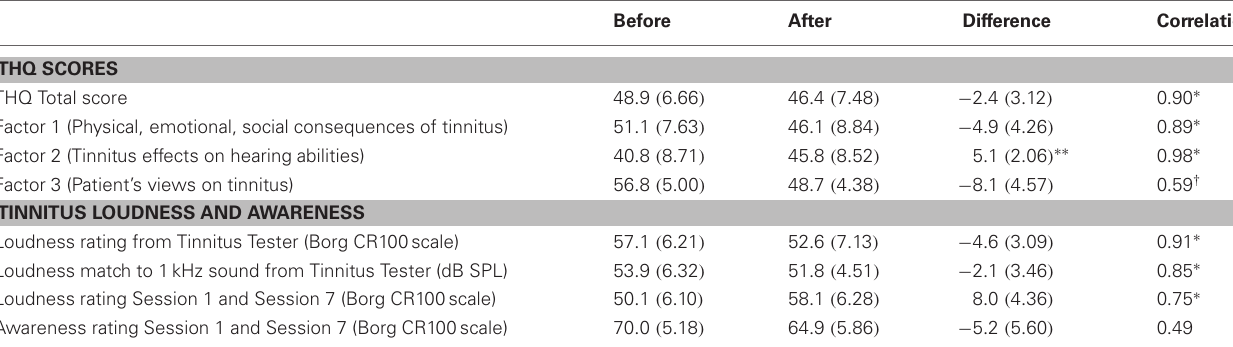
Table 2 | Tinnitus Handicap Questionnaire and Tinnitus Loudness.